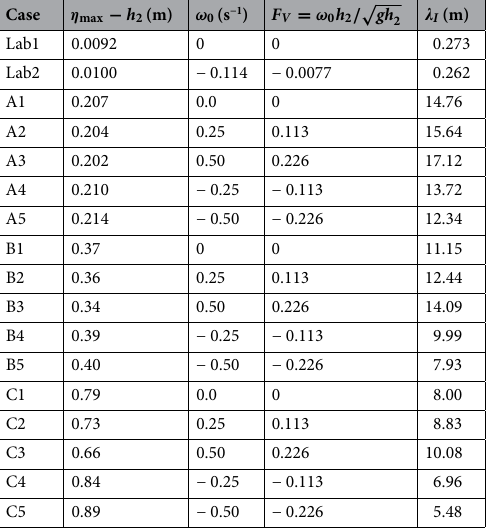
Table 1. Conditions for solitary wave cases. η max is the maximum water depth from the bottom, h 2 is the initial water depth, ω 0 is the vorticity, and (cid:31) I is the effective wavelength.